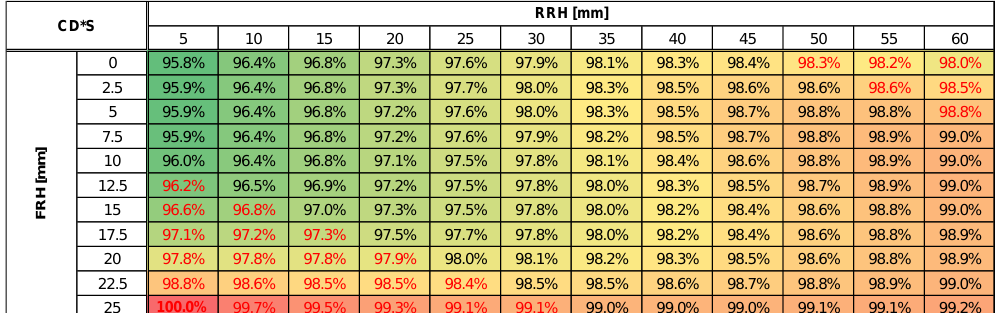
( b ) Figure 4. Pressure coefficient Cp in front and rear view: ( a ) front view showing stagnation pressure areas; ( b ) rear view showing low pressure areas under rear wing and in underbody Venturi ducts. Figure 5. Pressure coefficient Cp under the car, showing main downforce contributions through ground effect. What is relevant here is that such a sweep enabled generation of the so-called aero- dynamic maps, therefore replacing experimental testing in the wind tunnel. These 2D look-up tables describe the functional properties of the car in terms of aerodynamic per-